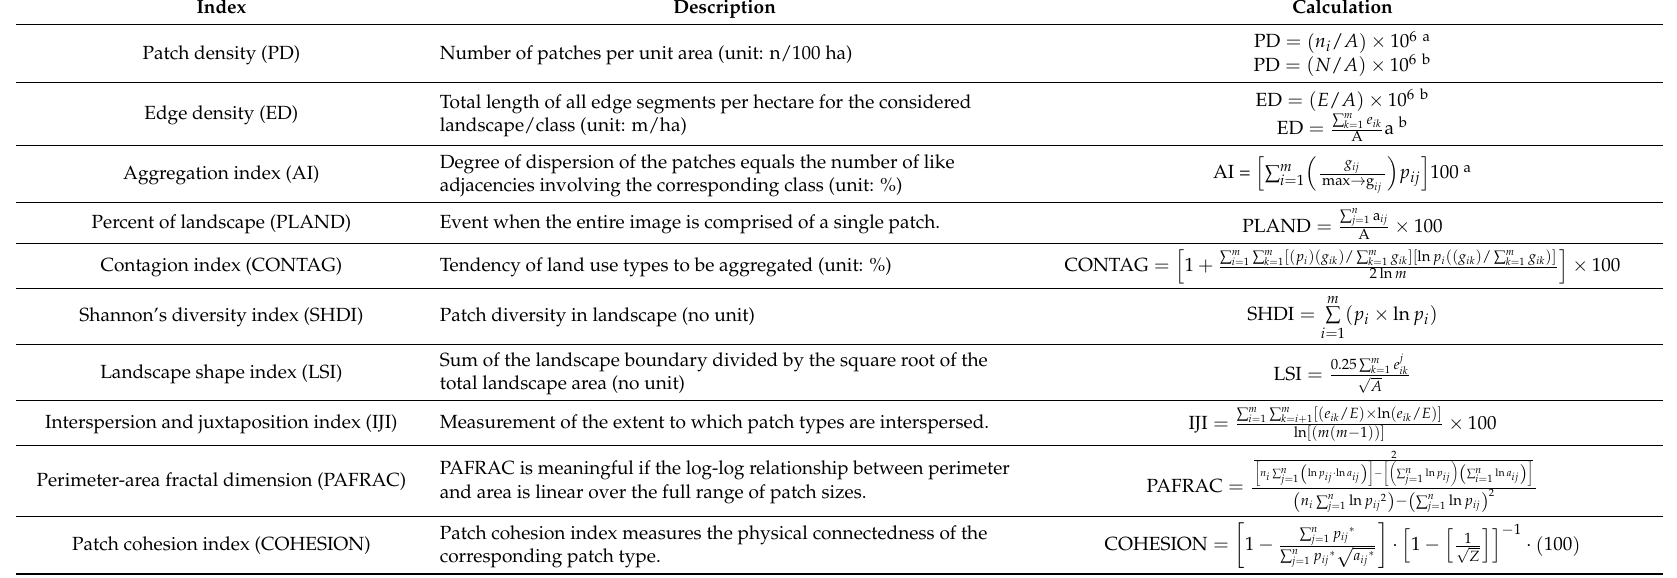
Table 2. Landscape metrics at class and landscape levels used in this